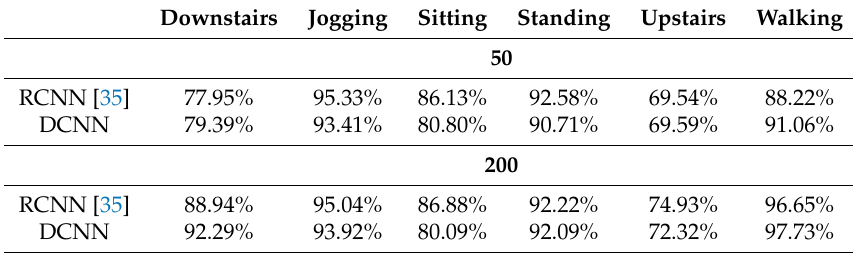
Table A2. Average recall scores of the 10-fold cross-validation of the WISDM